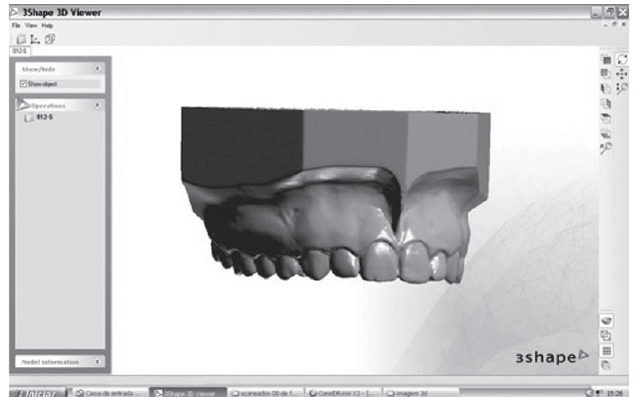
Fig. 1. Print screen of the right maxillary central